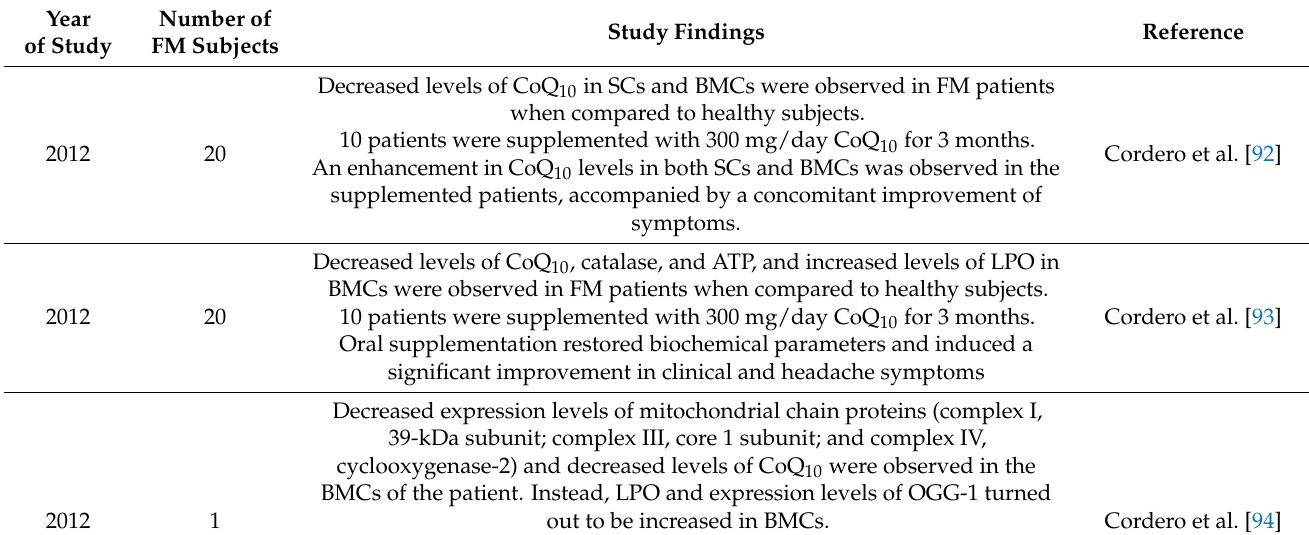
Table 2. Summary of studies investigating the effects of CoQ 10 supplementation on FM